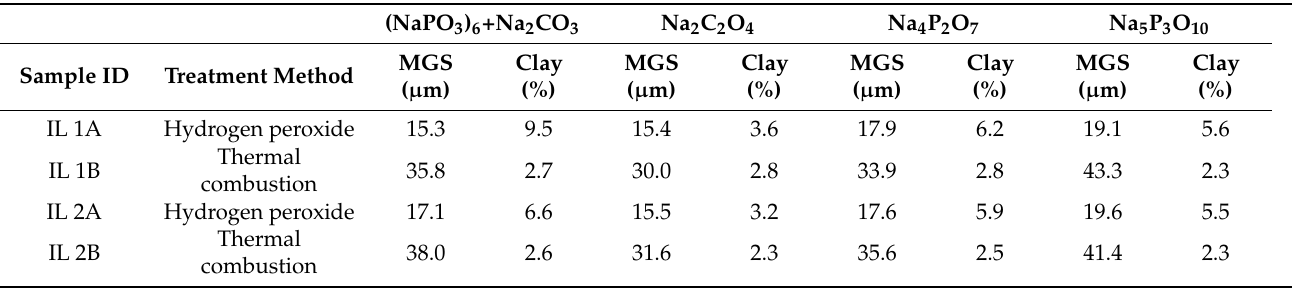
Table 4. Summary of statistical grain size parameters; mean grain size (MGS), and clay content for samples IL1 and IL2, with Group A being treated using hydrogen peroxide and Group B with thermal combustion.